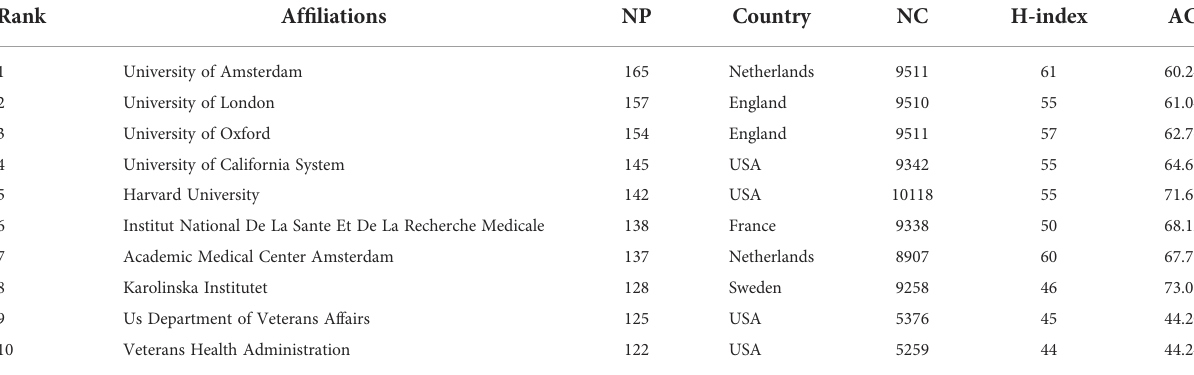
TABLE 2 Top 10 productive af fi liations in macrophages-related RA from 2000 – 2021. Rank